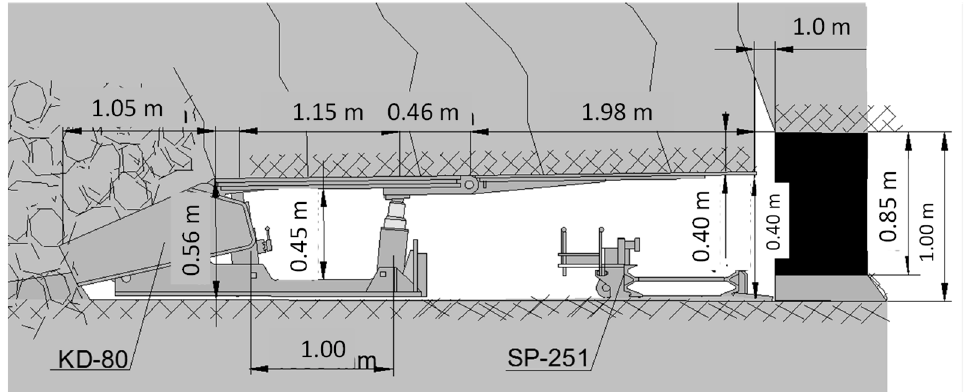
Figure 4. Cutting of the roof rock along the stope line, resulting in rigid settlement of the support units.